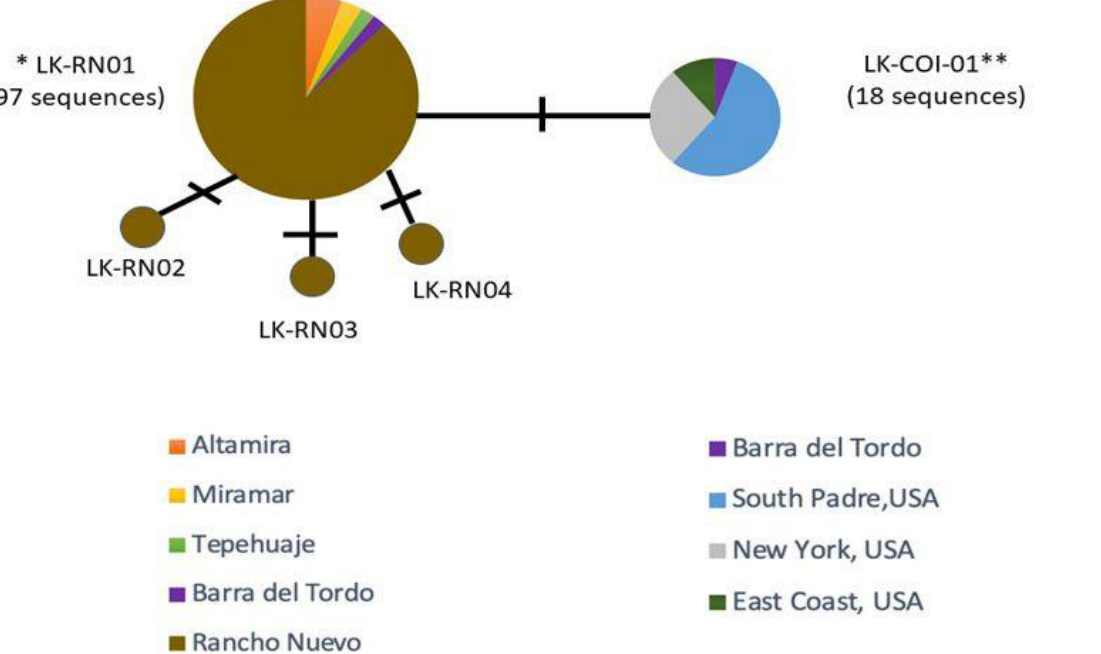
Figure 2. Haplotype network of the 5 haplotypes found for Kemp’s ridley ( Lepidochelys kempii ) using COI sequences obtained from BOLD and specimens collected in Mexico, 2010, 2016, 2018. The size of the circle indicates the number of individuals that share the same haplotype, and the colors correspond to different sampling locations. The small line indicates a mutation step. * New Haplotypes. ** Previously reported haplotype. Table 1. Mitochondrial haplotypes were obtained for 118 COI sequences from Kemp’s ridley ( Lepidochelys kempii ) in BOLD and field samples collected in Mexico, 2018–2019; Nucleotides change positions related to the consensus sequence (113 or 716, GenBank accession, respectively), number of sequences (n), number of haplotypes ( H ), nucleotide (Pi), and haplotype (h) diversities, and G +